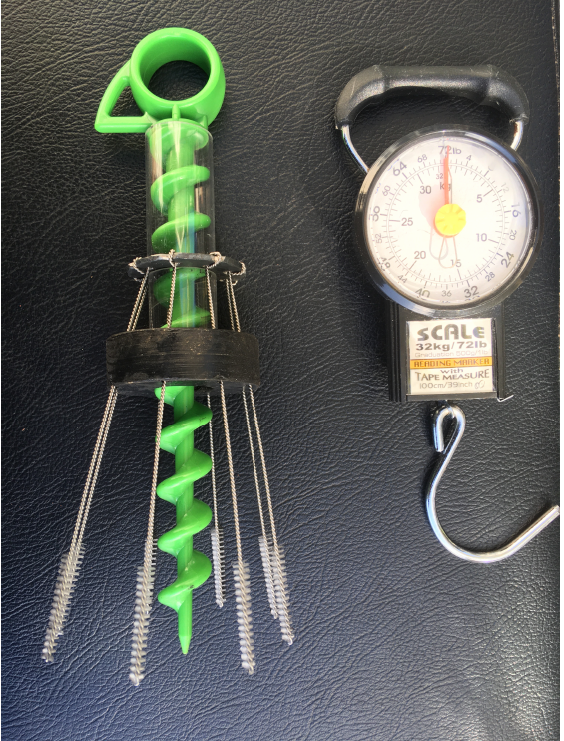
Figure 12. The RAATM anchoring strength test prototype and